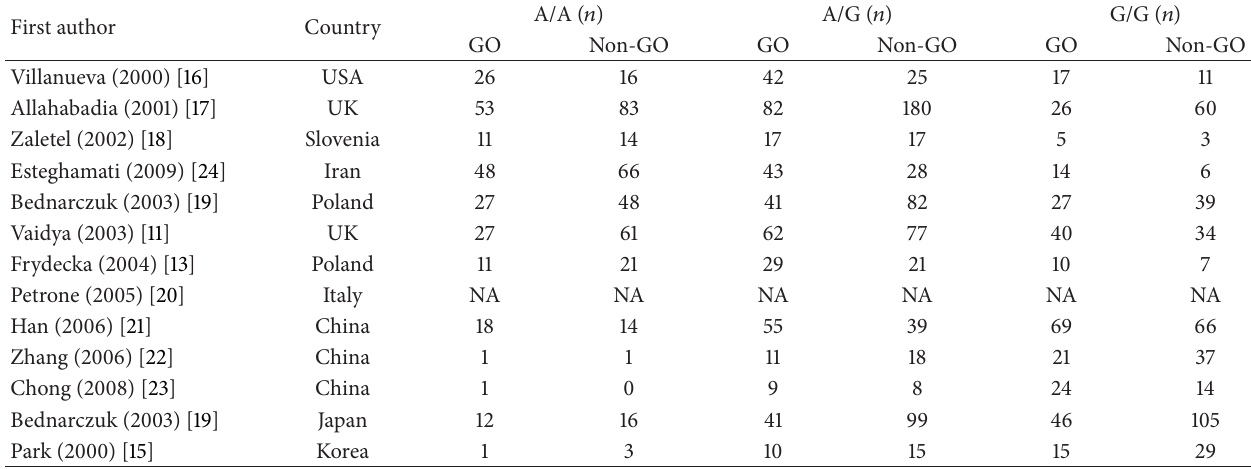
Table 2: Distribution of CTLA4 49A/G alleles among GO and controls in the included